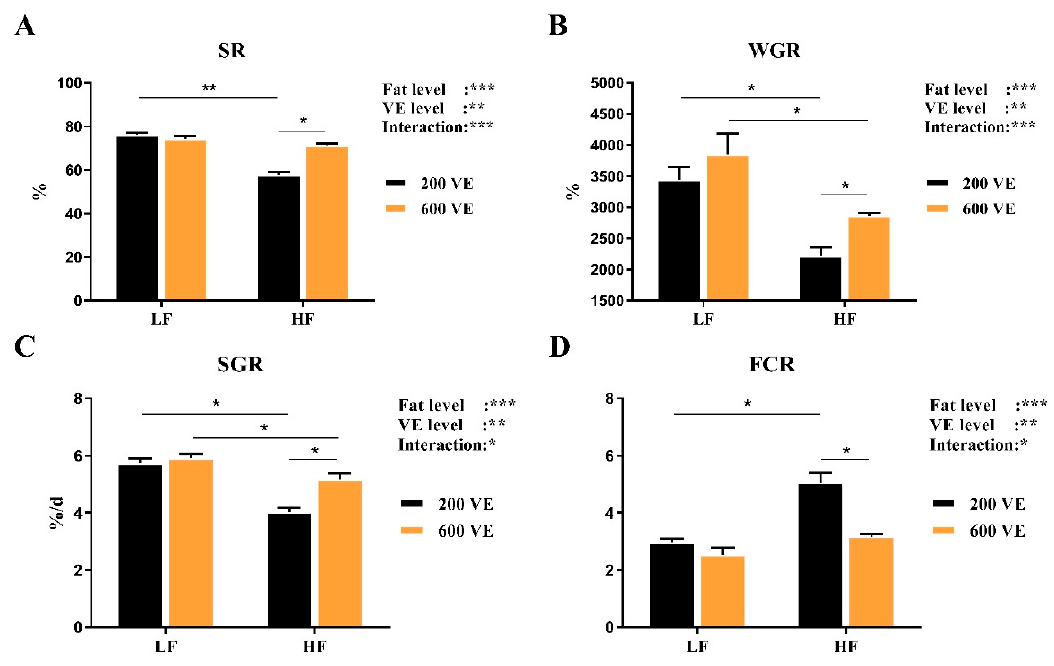
Figure 1. Growth performance and feed utilization of Macrobrachium rosenbergii fed with different dietary fat and VE levels. ( A ) survival rate (SR, %) of M. rosenbergii fed with different dietary fat and VE levels; ( B ) Weight gain rate (WGR, %) of M. rosenbergii fed with different dietary fat and VE levels; ( C ) specific growth rate (SGR, %/day) of M. rosenbergii fed with different dietary fat and VE levels; ( D ) feed conversion ratio (FCR) of M. rosenbergii fed with different dietary fat and VE levels. Values are means ± SEM. ***: p < 0.001, **: p < 0.01, *: p < 0.05. WGR = (final weight − initial weight) × 100/initial weight; SGR = (Ln final weight − Ln initial weight) × 100/day; FCR = feed consumption (g)/weight gain (g); SR = final number of prawns/initial number of prawns.